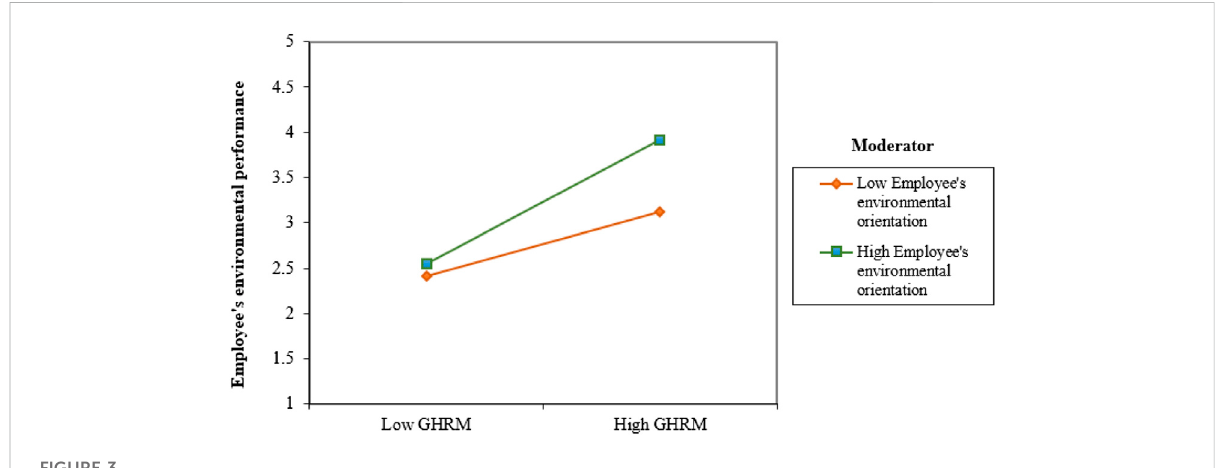
FIGURE 3 Moderation of employee ’ s environmental